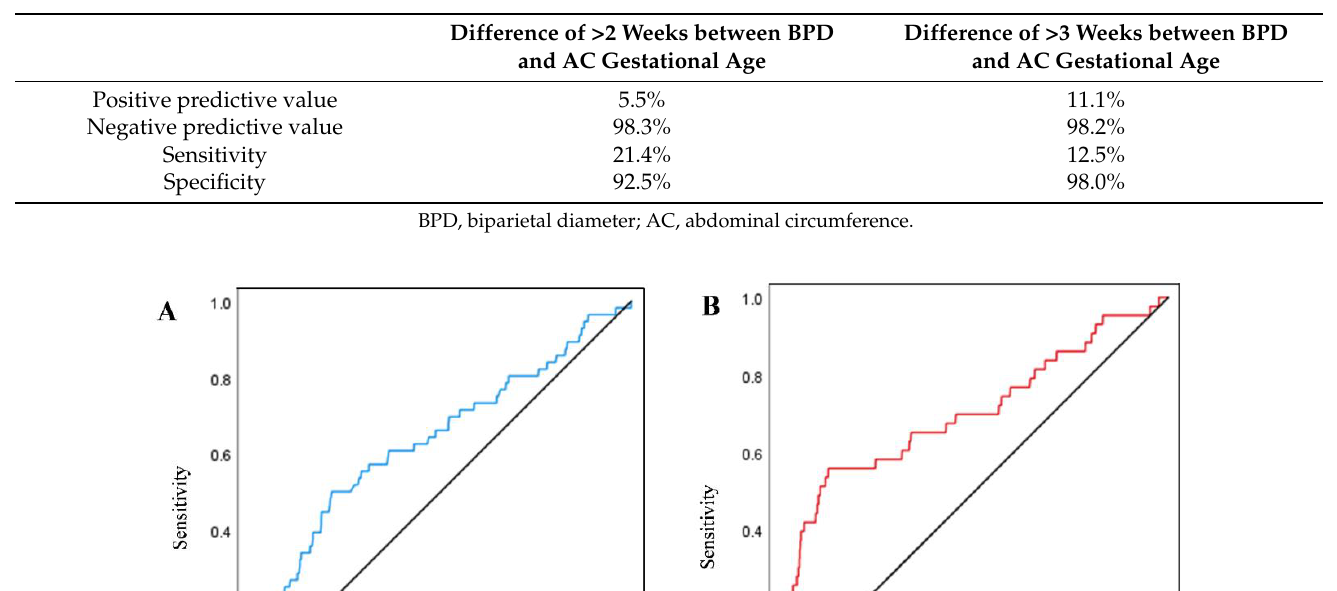
Table 4. Diagnostic performance for prediction of placental abruption.